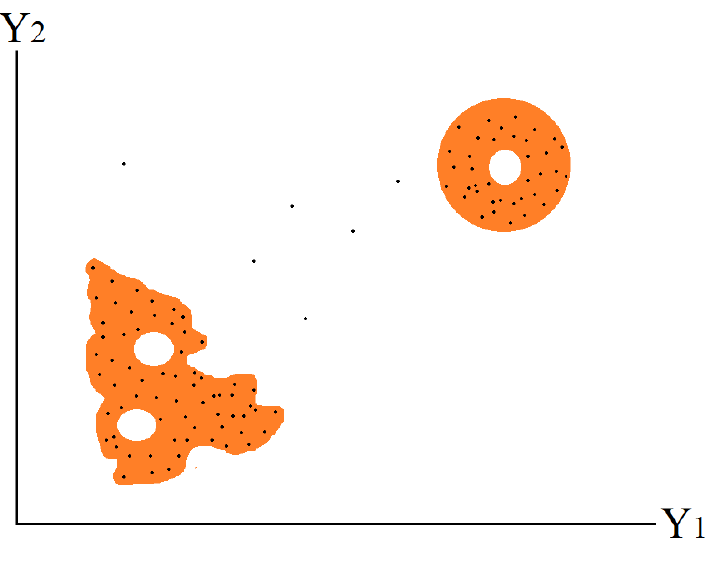
Figure 2. The two clusters of the data set and their topological